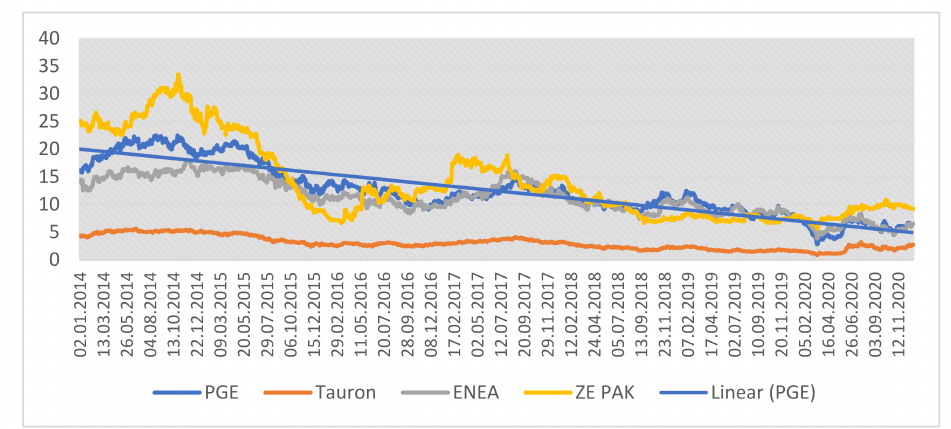
Figure 5. Share prices of PGE, TAURON, ENEA and ZE PAK during the period from 2 January